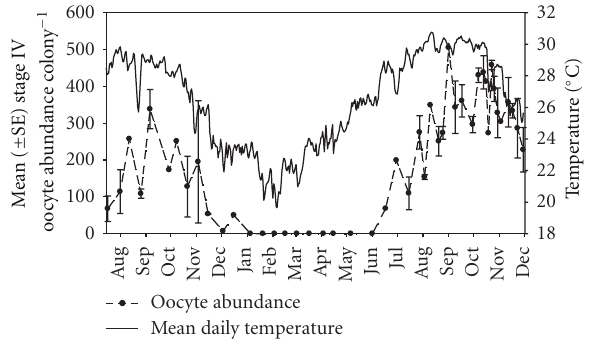
Figure 6: Solenastrea bournoni mean ( ± SE) abundance of stage IV oocytes per colony at each sampling date with temperature for sampling dates 2008 through 2009.